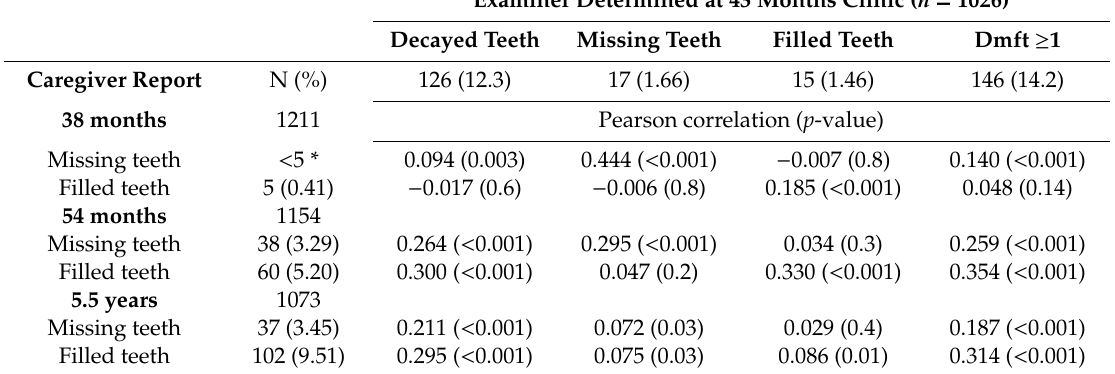
Table 3. Measures of correlation between caregivers’ assessments of children’s dental disease status at 38 months, 54 months, and 5.5 years and clinically determined oral disease status at 43 months of age. Examiner Determined at 43 Months Clinic ( n = 1026)